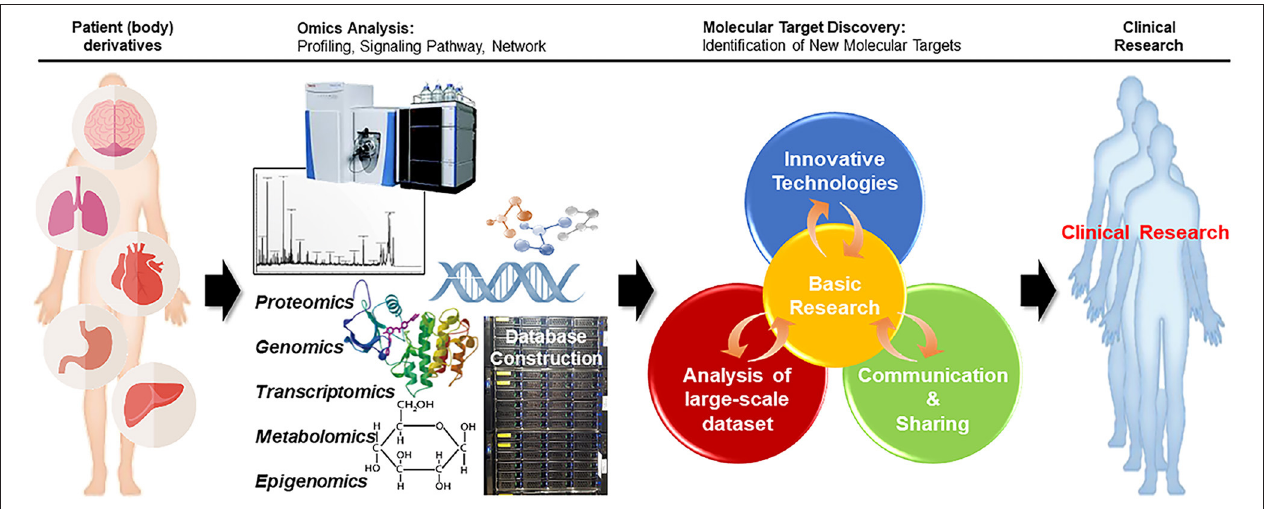
FIGURE 2 | Reverse translational research strategy. In reverse translational research, in-depth multi-omics analysis of cancer specimens from patients can improve our understanding of the molecular basis of cancer, facilitating the discovery of new target molecules. Further clinical research with patients can aid in finding better approaches for the treatment of